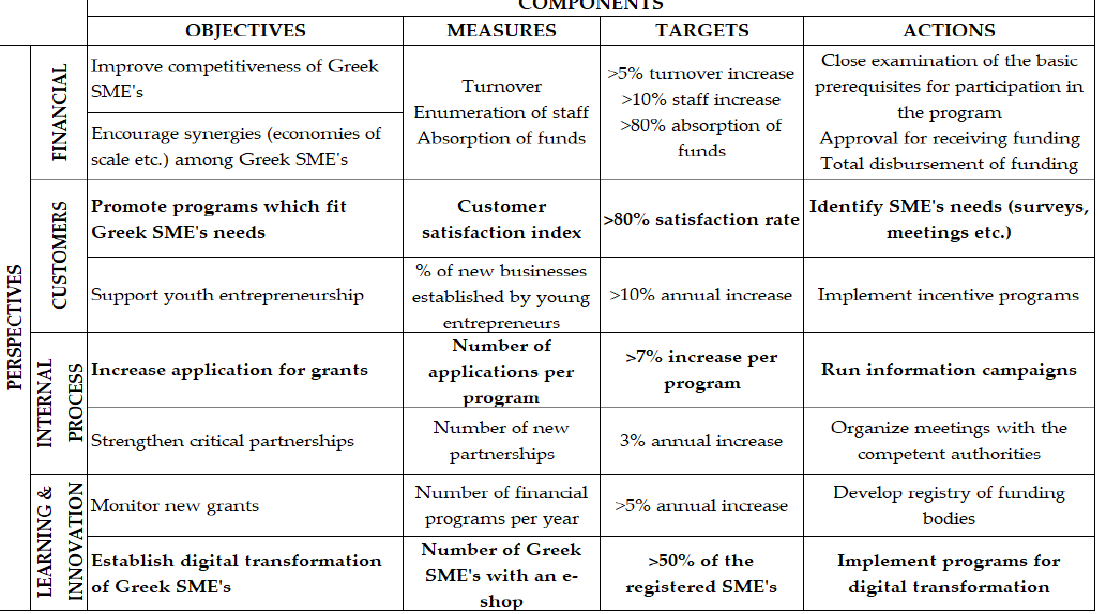
Figure 1. The Balanced Scorecard (Psarras et al. 2020).